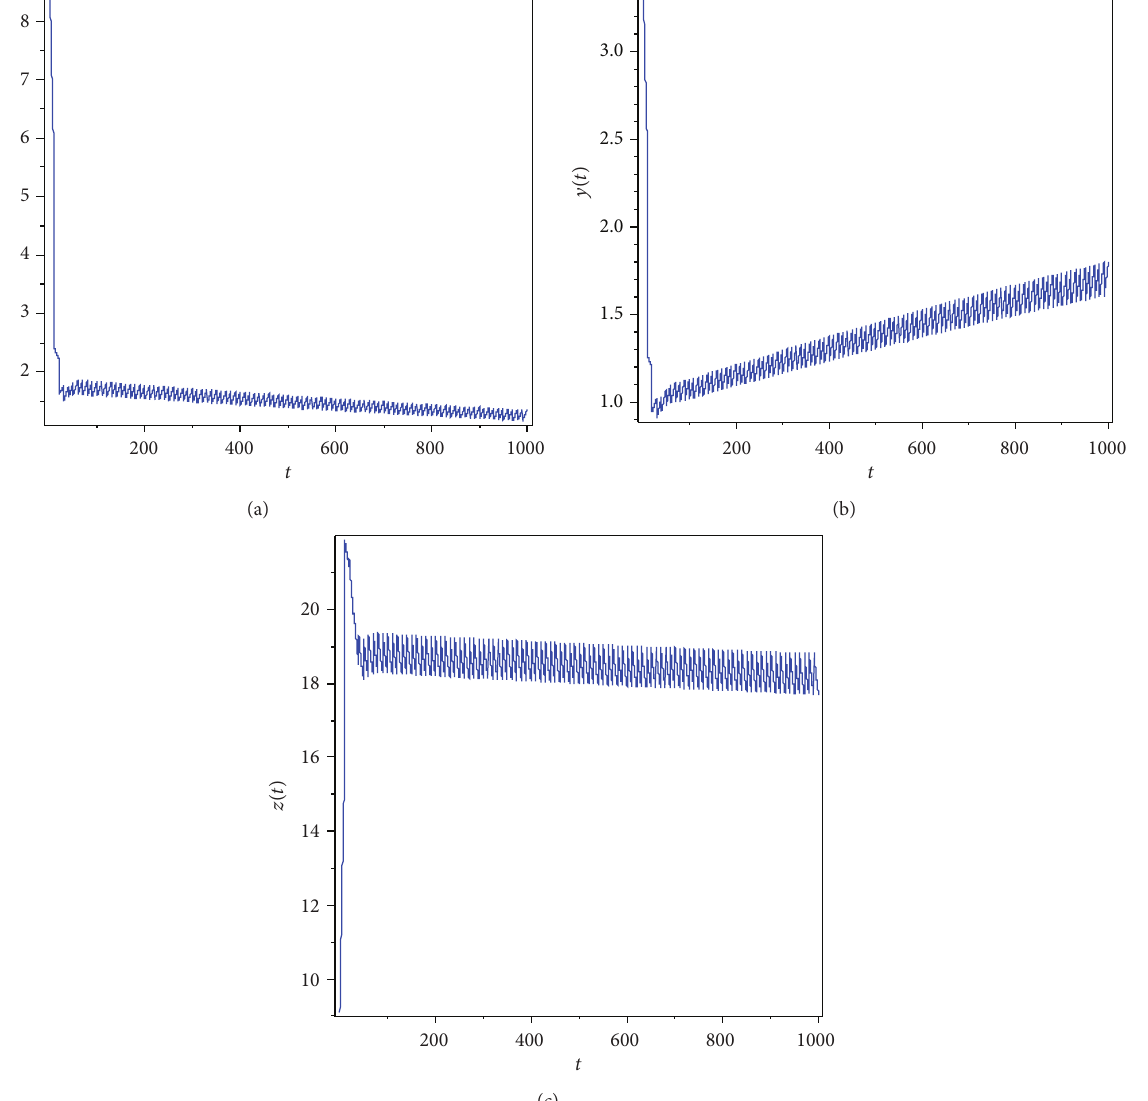
Figure 3: Time series of a solution of model (6) with 𝑞 = 6 : (a) time series of the prey population 𝑥(𝑡) ; (b) time series of the prey population 𝑦(𝑡) ; (c) time series of the predator population 𝑧(𝑡)